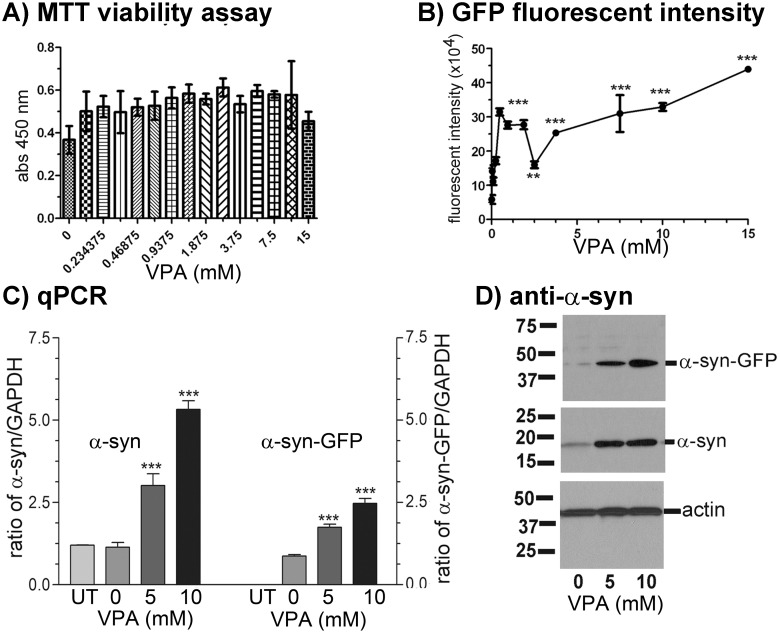
Effect of valproic acid (VPA) treatment on α-syn-GFP fusion protein expression in GFP12 cells.GFP12 cells were grown in 384-well plates with VPA in DMEM/FBS medium. GFP intensity was measured using a DTX880 plate reader with excitation wavelength set at 485 nm and emission wavelength set at 535 nm, followed by MTT viability assay. (A) MTT viability assay shows that GFP12 cell growth was not significantly affected by increasing VPA concentration. (B) Effect of VPA on GFP12 fluorescent intensity. Fluorescent intensity of GFP12 cells increased with higher concentrations of VPA. Data were analyzed by One-way ANOVA (P <0.0001, n = 5) followed by Tukey’s multiple comparison test. Values were expressed as Mean ± SD. (C) qPCR and (D) Western blots of VPA treated GFP12 cells. qPCR shows significant increase of both wild type (α-syn) and GFP tagged α-synuclein (α-syn-GFP) mRNA. Similarly, Western blots using α-syn antibody 211 show that VPA treatment caused a significant dosage-dependent increase in the expression of both wild type α-synuclein and α-syn-GFP fusion protein by GFP12 cells. * P < 0.05, ** P < 0.01, *** P < 0.001.